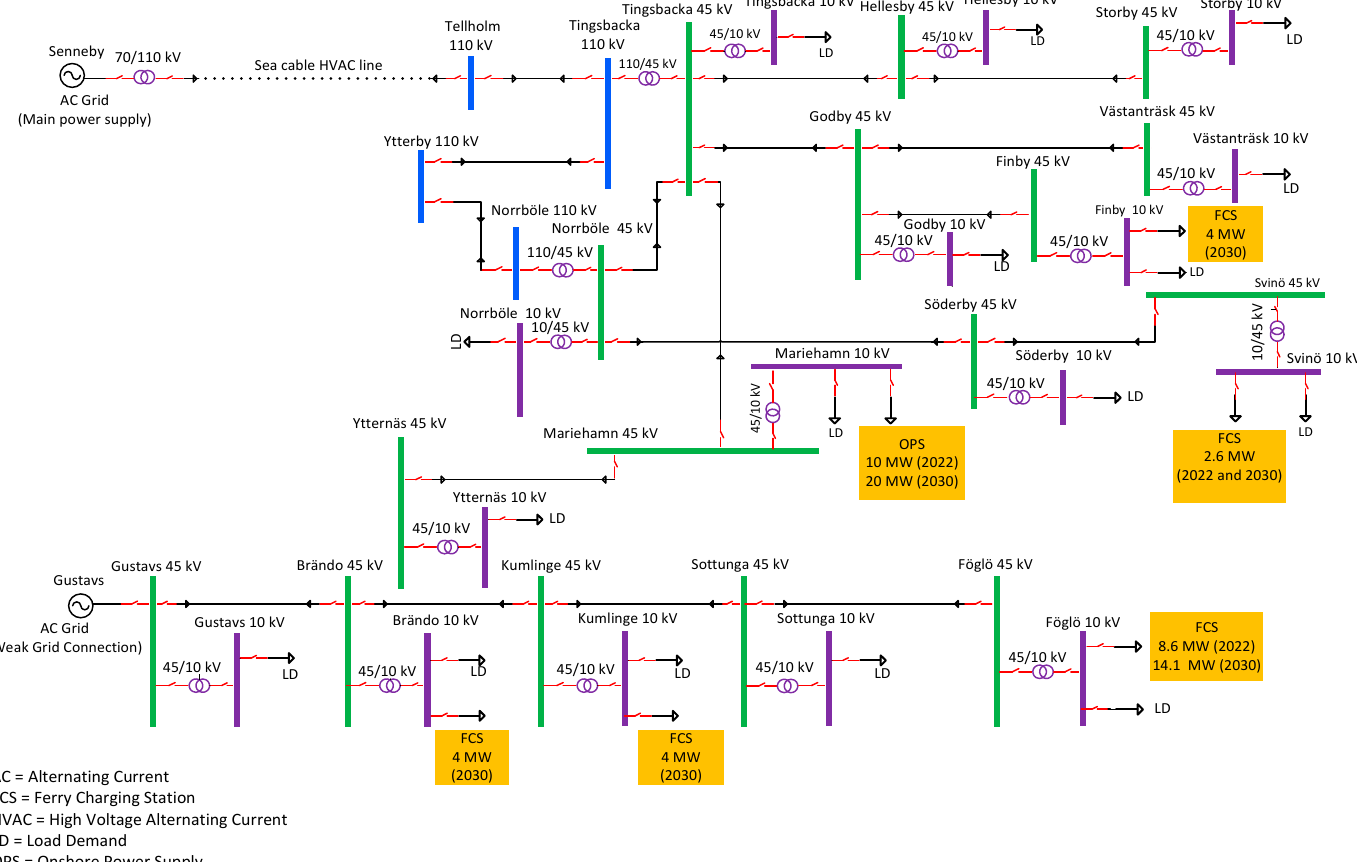
Figure 8. Single line diagram of the electricity network in thr Åland Islands for base case studies without BESSs.